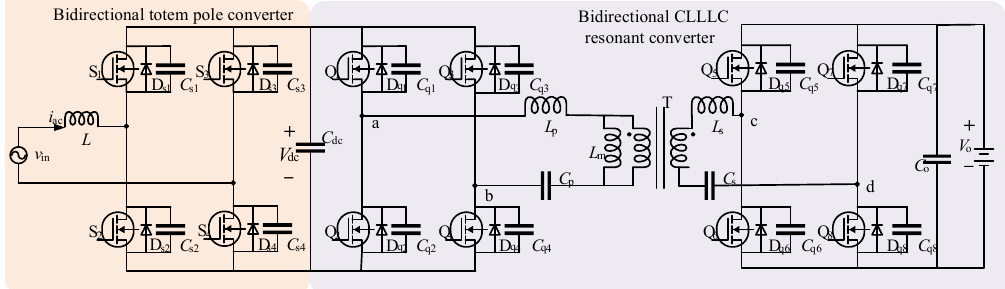
Figure 2. Main topology of the charging system.